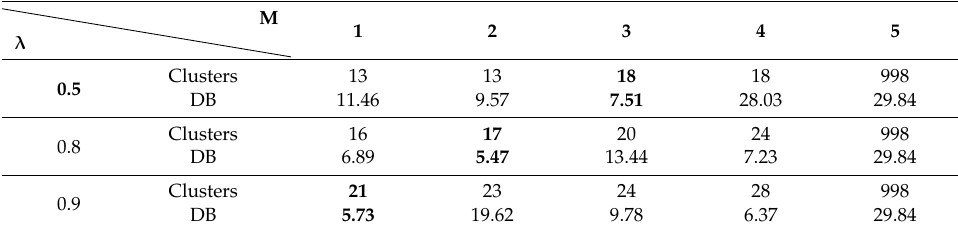
Table 5. Clustering results under di ff erent λ